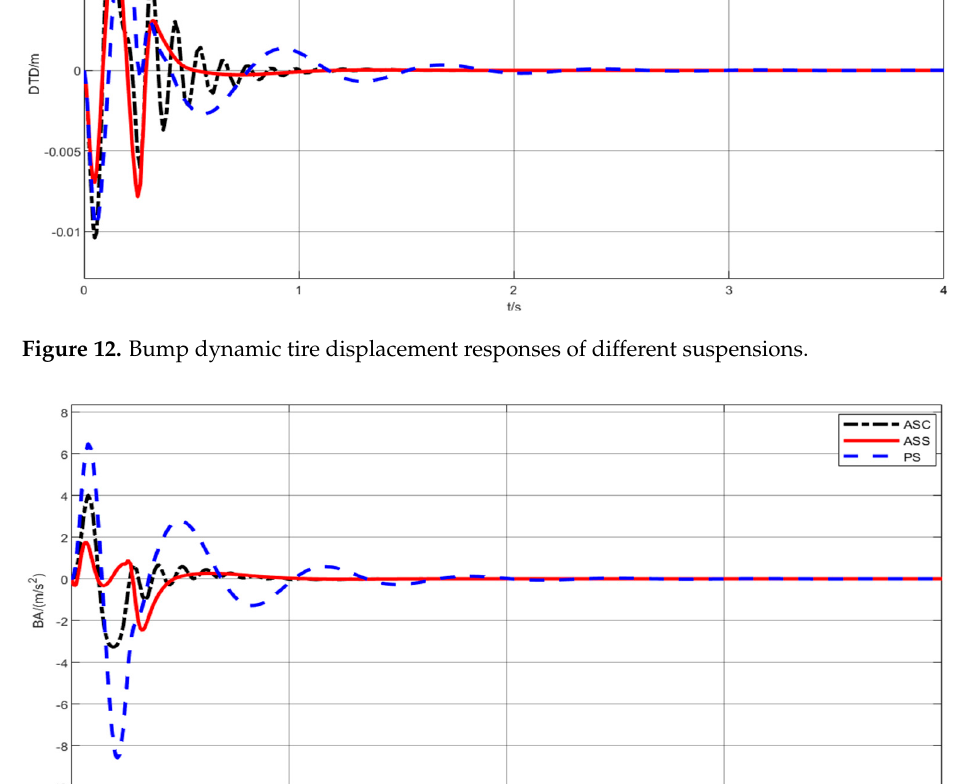
Figure 13. Bump body acceleration responses of different suspensions with 20% mass variation.